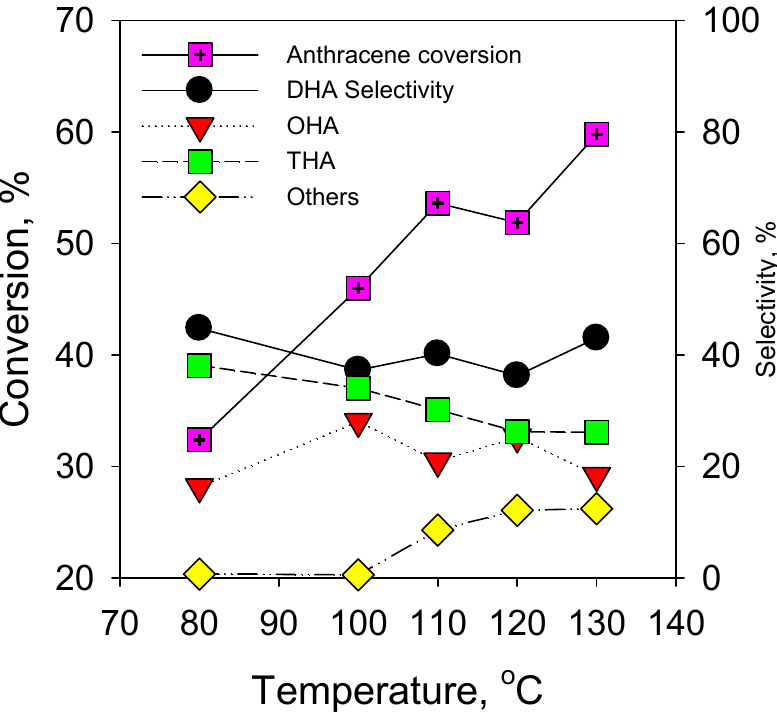
Figure 3. Effect of temperature on hydrogenation of anthracene over 10 wt.% Ni/H β -zeolite catalyst. Catalyst weight: 0.5 g; Reaction pressure: 6.9 MPa; H volume of the reactor: 50 mL; reaction time: 6